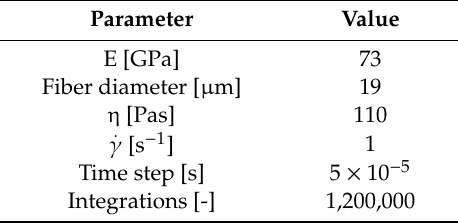
Table 3. Shear cell properties for injection- and compression molded samples.